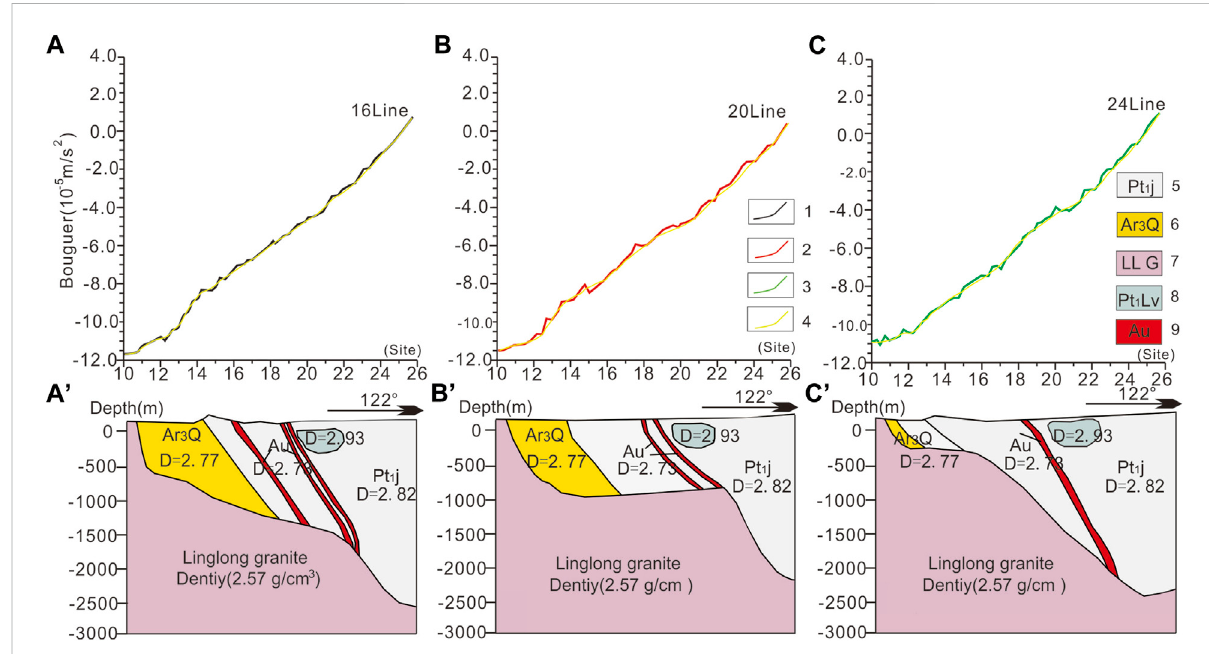
FIGURE 6 Man machine interactive inversion of three gravity pro fi les. (A – C) Observation curves and fi tting curves; (A ’– C ’ ) Geologic interpretation. 1- Observationcurve16line; 2- Observation curve20line; Observation curve24 line; 4-Fitting curve; 5- PaleoproterozoicJinshan Group;6- Archean